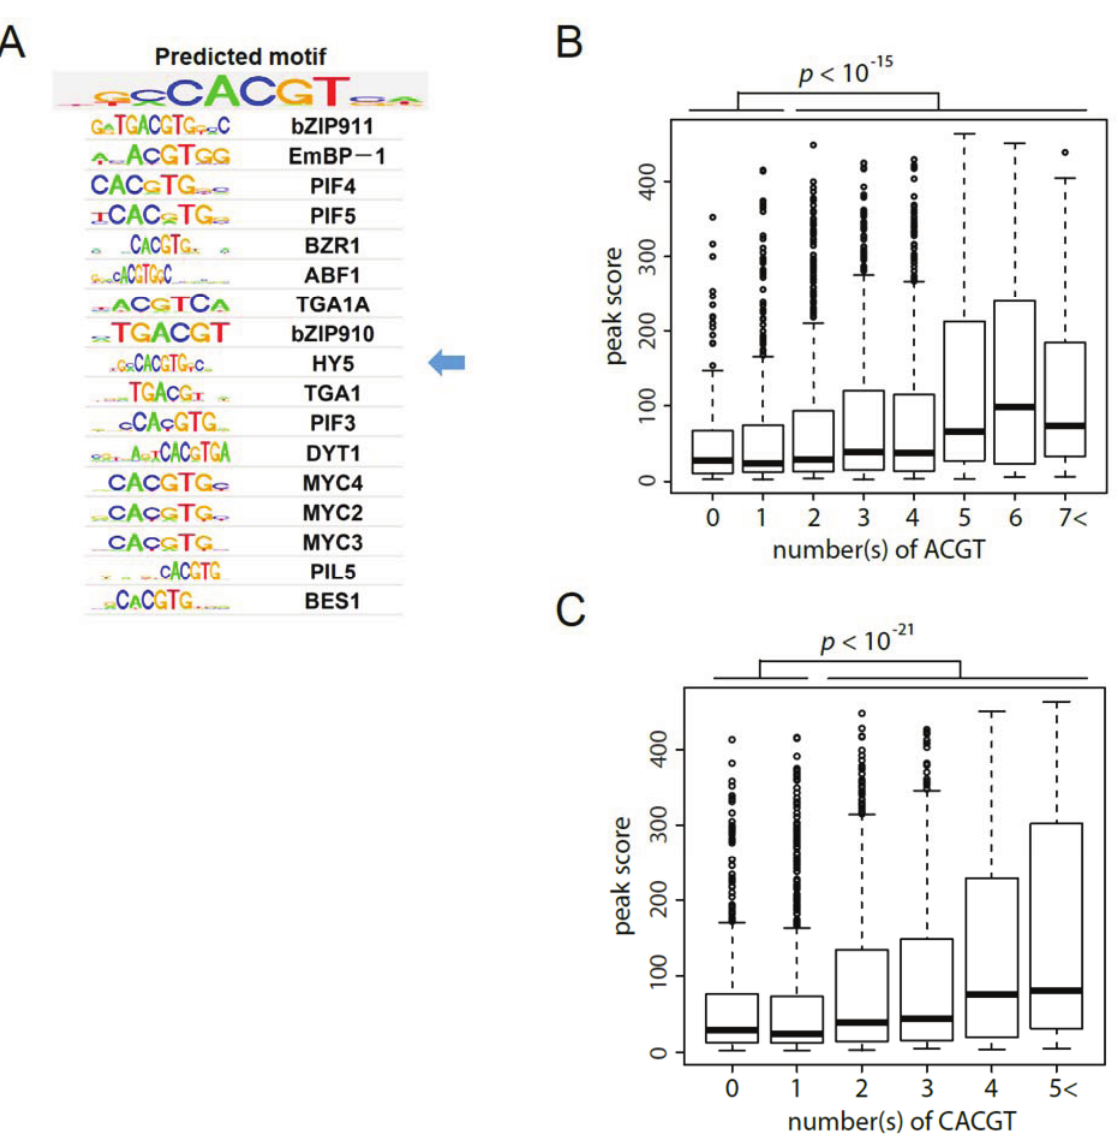
Figure 3. Motif prediction of HY5-binding sequence. ( A ) Results of the HY5-binding motif prediction and similarity search in the JASPAR database. Seventeen TFs with similar motifs as those of HY5 are shown under the predicted motif. Arrow indicates a HY5 binding motif registered in the JASPAR database. ( B ) and ( C ) box plots of the distribution of peak scores to number(s) of ACGT ( B ) and CACGT ( C ) sequence(s), respectively. p -values of peak scores between categories (0 and 1) and (2<) are shown above boxplots. Peak numbers included in each category of ( B ) and ( C ) are 219 (0), 498 (1), 599 (2), 562 (3), 378 (4), 163 (5), 68 (6) and 33 (7<), and 544 (0), 809 (1), 659 (2), 344 (3), 113 (4) and 51 (5<),